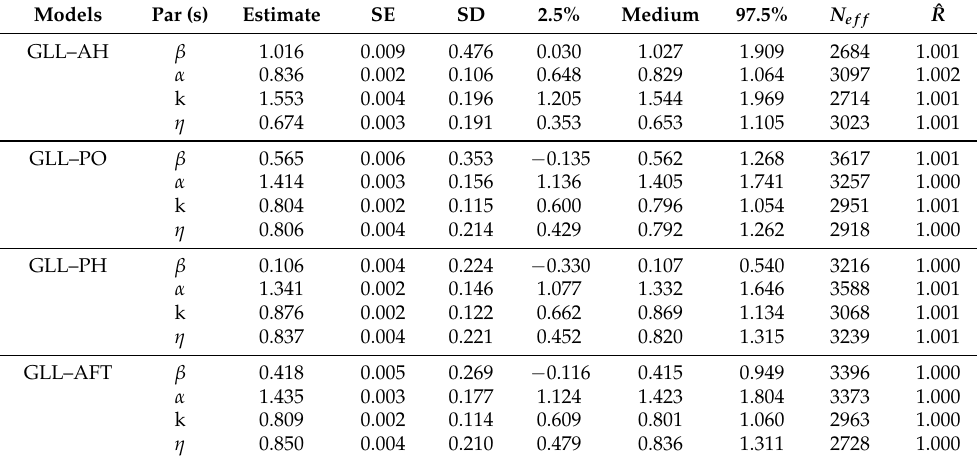
Table 5. Results for the posterior properties of the GLL–AH, GLL–PO, GLL–PH and GLL–AFT models.